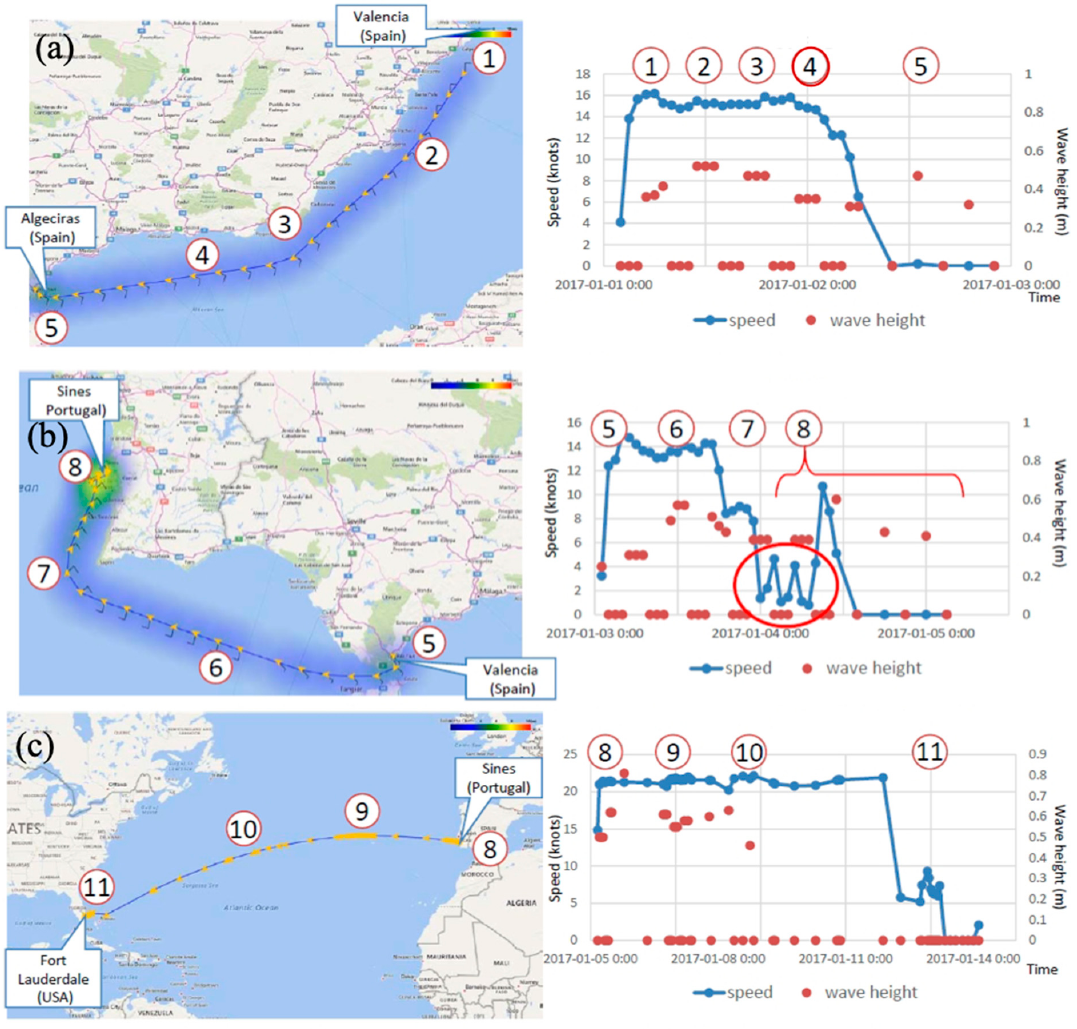
Figure 6. Analysis of the previous trajectories with ocean environmental conditions in Figure 5. ( a ) Voyage 1, 1~2 January, 2017, ( b ) Voyage 2, 3~4 January, 2017, ( c ) voyage 3, transatlantic route, from 5 to 13 January, 2017.